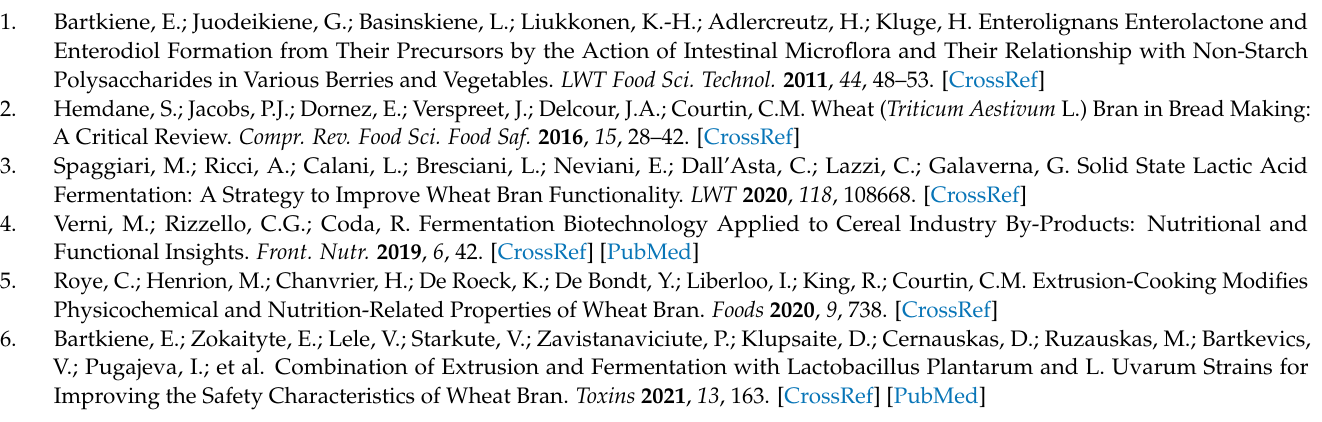
bran, Table S1. Acidity, microbiological parameters, and sugar concentration in processed wheat bran; Table S2. Amino acid concentration (g/100 g) in processed wheat bran; Table S3. Biogenic amines concentration (mg/kg) in processed wheat bran; Table S4. Mycotoxin concentration ( µ g/kg) in processed wheat bran; Supplementary File S2: Procedure of the FaceReader